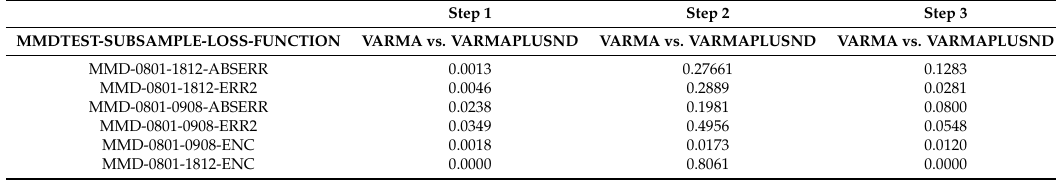
Table 5. Tests of equal predictive accuracy and test of forecast encompassing of VARMA using only hard data and both hard data and soft data, respectively, (i.e., ISTAT survey) for non-durable goods. The forecast windows expands itself from 2008:01 to 2018:12. The three tests are considered at the end of the sample and at the maximum value of forecast benchmark, i.e., August 2009. The p -values near one show that null hypothesis of equal predictive accuracy between the VARMA that uses only hard data and the VARMA that uses hard data plus soft data for non-durable goods has been accepted. For encompass test, the null hypothesis is that the forecast of the VARMA using only hard data encompasses the forecast of the VARMA using only hard data and soft data for non-durable goods. Step 1 Step 2 Step 3 MMDTEST-SUBSAMPLE-LOSS-FUNCTION VARMA vs. VARMAPLUSND VARMA vs. VARMAPLUSND VARMA vs. VARMAPLUSND